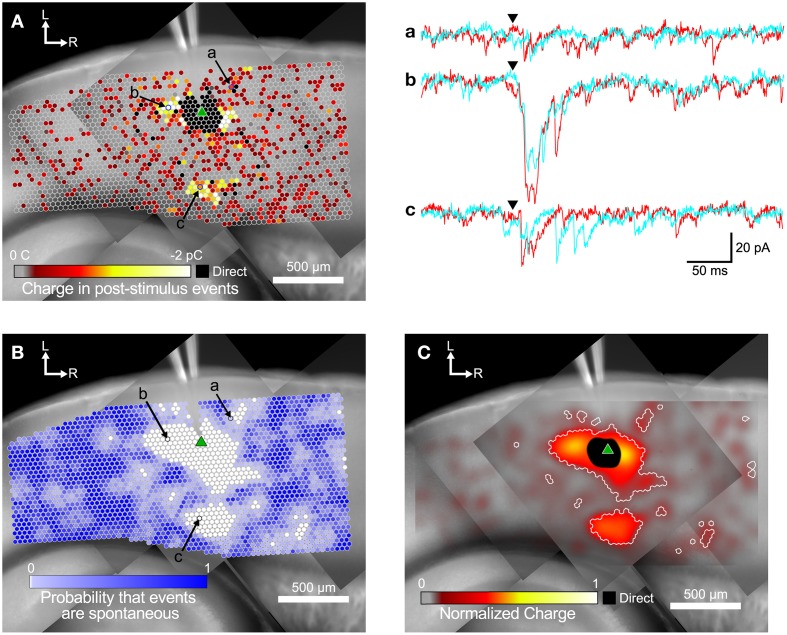
Steps in the analysis of input maps. (A) Color-coded maps showing detected events are superimposed over a mosaic image of the slice. The recording electrode is visible at the top center of the image. The slice was stimulated at each site (indicated by circles) while recording from a target cell (marked by green triangle). Spots where events were detected are colored according to the sum of the charge in the detected events, with hotter colors (white and yellow) indicating a larger charge. Example traces for two repeated trials at the labeled spots in (A,B) are shown in a, b, and c to the right. Arrowheads indicate the time of the laser flash. (B) The same map as in (A), but spots are colored by the probability that events were spontaneous, as determined by the spatial correlation algorithm. (C) Same map as in (A,B). Here the charge measurements are normalized and smoothed with a Gaussian convolution that has the same width (σ = 45 μm) as the excitation profiles measured in Figure 1. Areas where the probability of events being spontaneous was <0.01 are outlined in white.